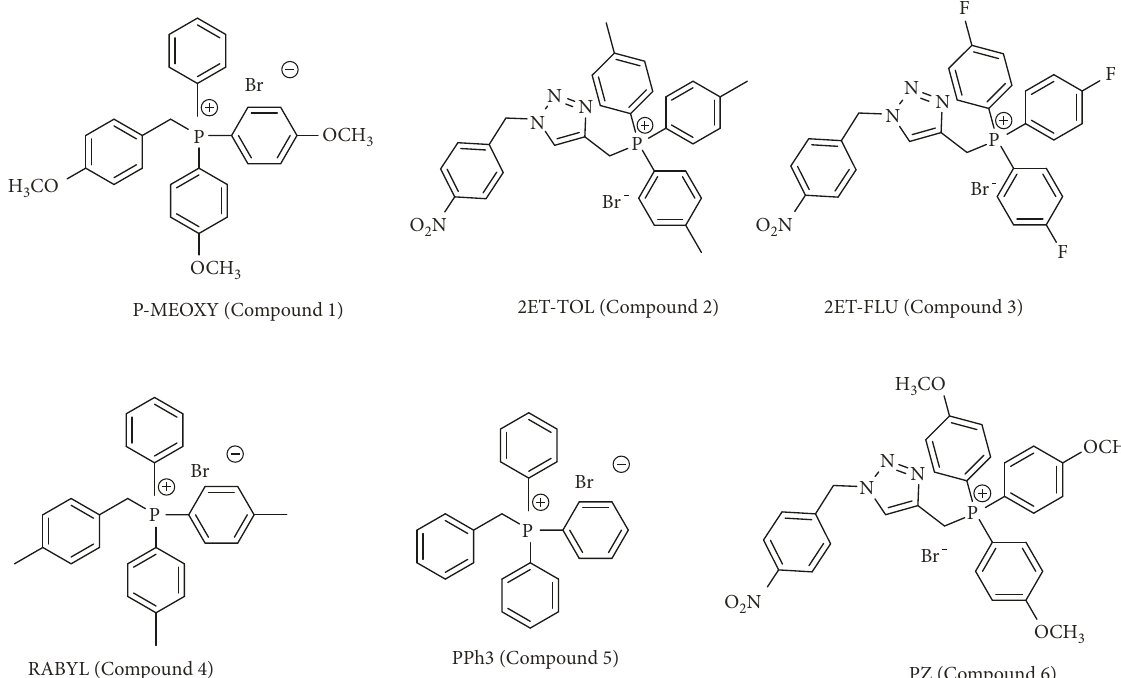
Figure 2: Chemical structures for the library of synthesized phosphonium salts (compounds 1–6), nonhybrids (1, 3, and 5), and hybrids (compounds 2, 3, and